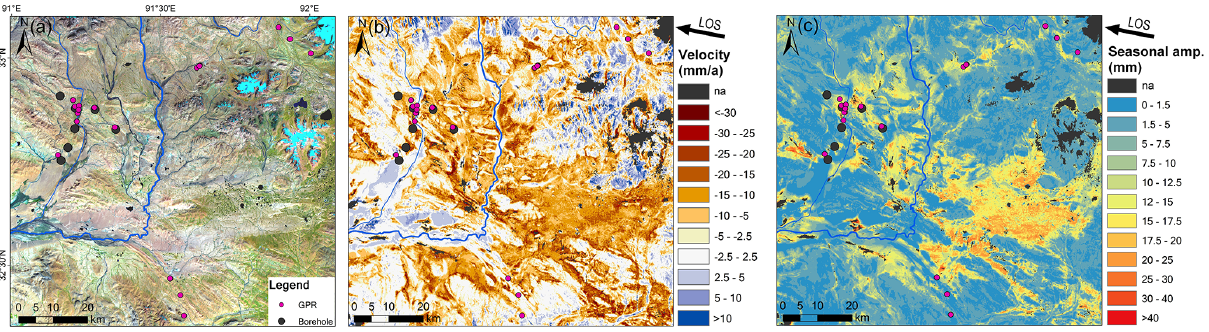
Figure A2. Maps of the GPR and borehole regions: (a) Landsat 8 image acquired in October 2020 (red: SWIR1, green: NIR, blue: red), with GPR and borehole sites marked; (b) long-term deformation velocity; (c) seasonal deformation amplitude.